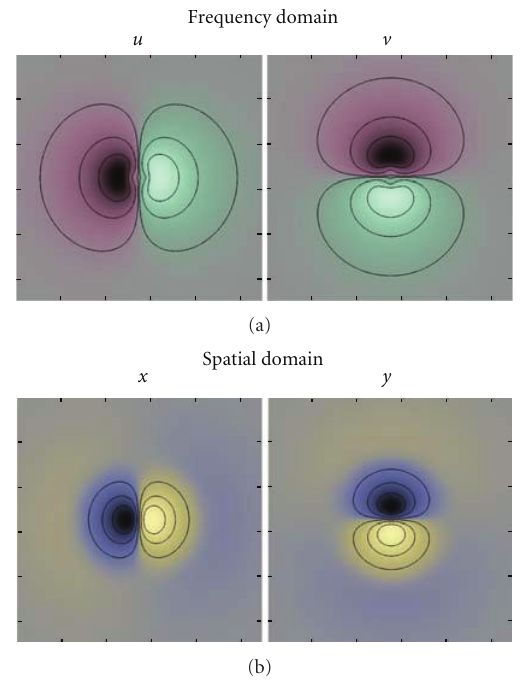
Figure 2: (a) Two-dimensional monomial filters ( u , v ), of the first order, in the frequency domain. Green indicates positive real values and red indicates negative real values. The black lines are isocurves. (b) Two-dimensional monomial filters ( x , y ), of the first order, in the spatial domain. Yellow indicates positive imaginary values, and blue indicates negative imaginary values. Note that these filters are odd and